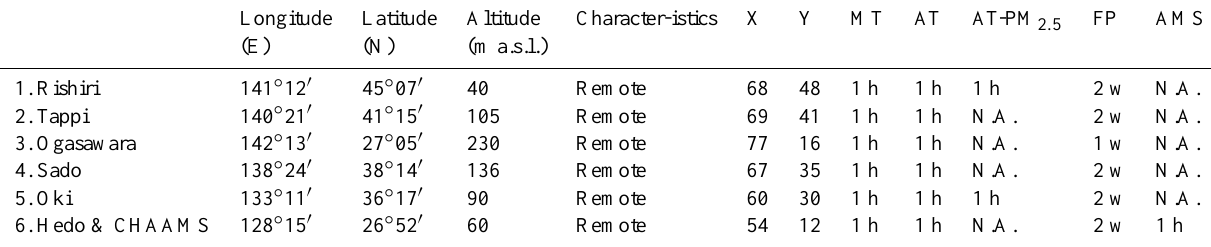
Table 4. Description of the EANET remote sites and the CHAAMS site used in this study. Each station is depicted in Fig. 1. Longitude Latitude Altitude Character-istics X Y MT AT AT-PM 2 . 5 FP AMS (E) (N) (m a.s.l.) 1. Rishiri 141 ◦ 12 0 45 ◦ 07 0 40 Remote 68 48 1 h 1 h 1 h 2 w N.A. 140 ◦ 21 0 41 ◦ 15 0 105 Remote 69 41 1 h 1 h N.A. 2 w N.A. 142 ◦ 13 0 27 ◦ 05 0 230 Remote 77 16 1 h 1 h N.A. 1 w N.A. 4. Sado 138 ◦ 24 0 38 ◦ 14 0 136 Remote 67 35 1 h 1 h N.A. 2 w N.A. 133 ◦ 11 0 36 ◦ 17 0 90 Remote 60 30 N.A. 128 ◦ 15 0 26 ◦ 52 0 60 Remote 54 1 h 1 h N.A. 1